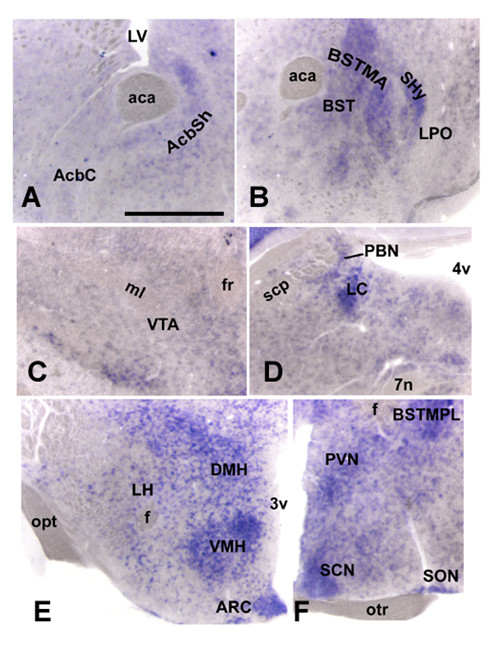
ISH detection of FTO mRNA in sites involved in the regulation of energy- or reward-related feeding. Panels A-D show sites affecting mainly reward, whereas panels E and F depict energy-related areas. aca, anterior commisure; AcbC, nucleus accumbens core; AcbSh, Acb shell; ARC, arcuate nucleus; BST, bed nucleus of the stria terminalis; BSTMA, BST medial anterior; BSTMPL, BST medial posterolateral; DMH, dorsomedial nucleus; f, fornix; fr, fasciculus retroflexus; LC, locus corelueus; LH, lateral hypothalamus; LPO, lateral preoptic area; LV, lateral ventricle; ml, medial lemniscus; otr, optic tract; PBN, parabrachial nucleus; PVN, paraventricular nucleus; SHy, septohypothalamic nucleus; SCN, suprachiasmatic nucleus; scp, superior cerebellar peduncle; SON, supraoptic nucleus; VMH, ventromedial nucleus; VTA, ventral tegmental area; 3v, 3rd ventricle; 4v, 4th ventricle; 7n, facial nerve. Scale bar: 0.4 mm (A, B) 0.5 mm (C-F).